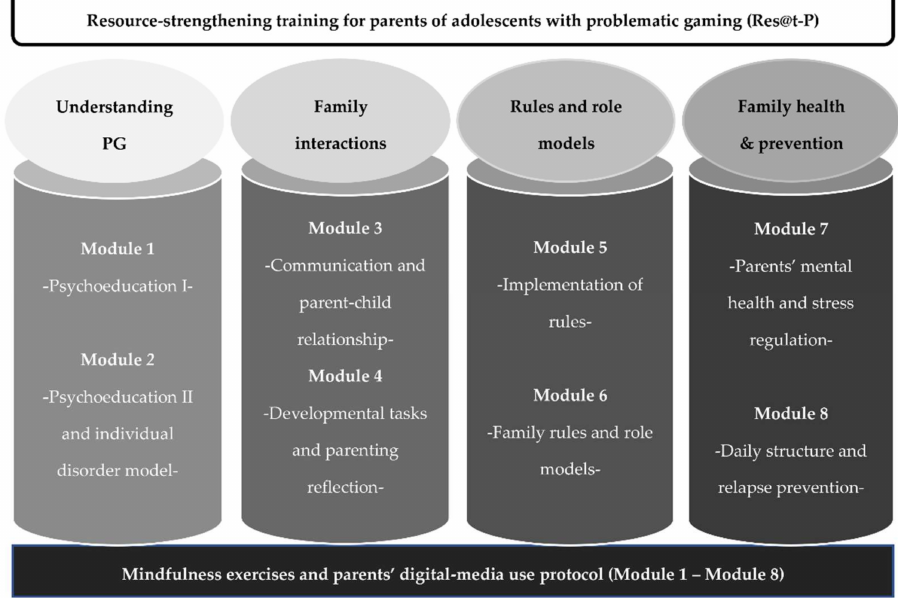
Figure 1. Thematic pillars of the training and content overview. Notes: PG = problematic